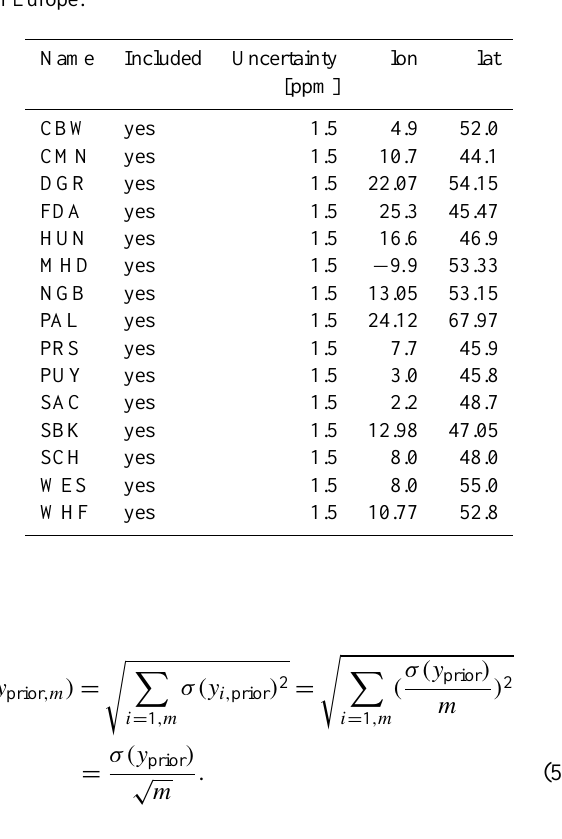
Table 4. Network cont of continuous atmospheric sampling sites over